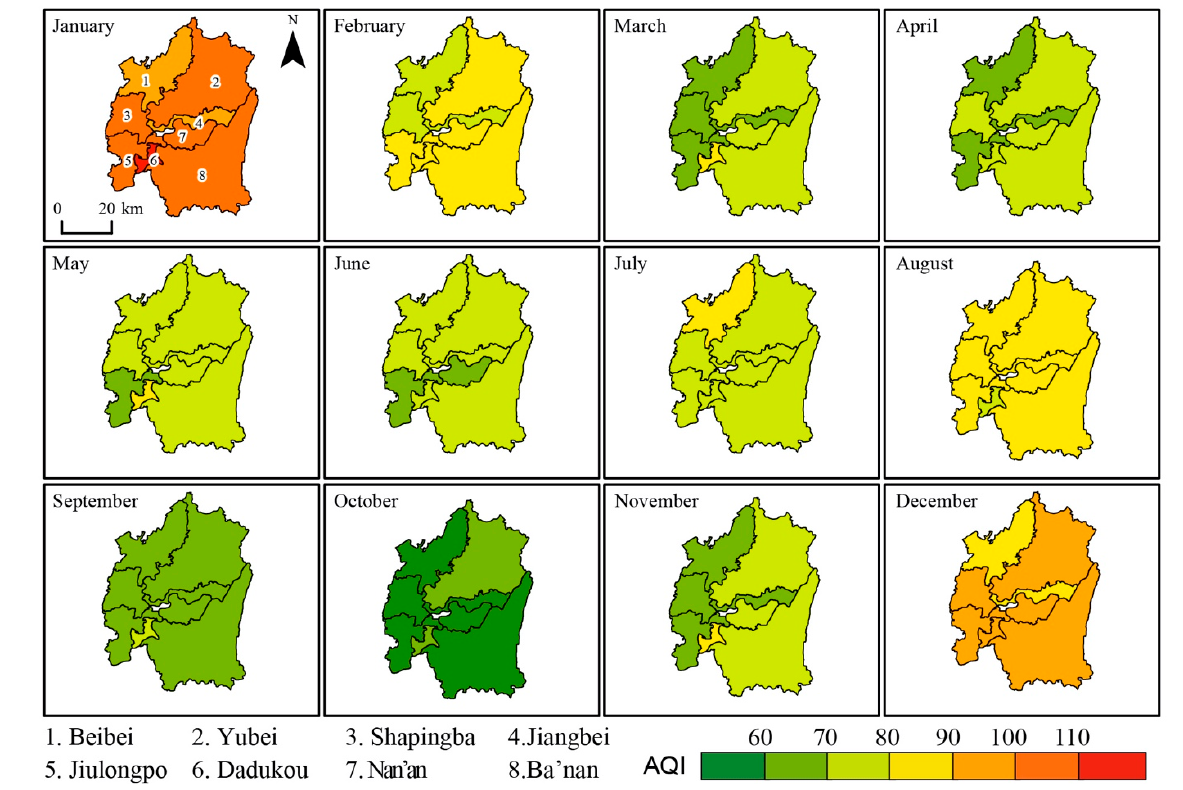
Figure 7. Spatial heterogeneity of monthly AQI from 2015 to 2021.